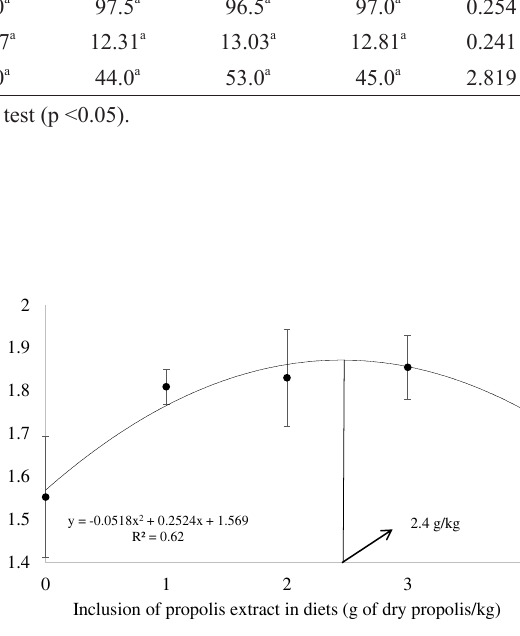
Figure 1 - Body condition factor of post-larvae of Nile tilapia Figure 1. Body condition factor of post-larvae of Nile tilapia fed with increasing levels of alcoholic 9 fed with increasing levels of alcoholic extract of propolis. extract of propolis. 10